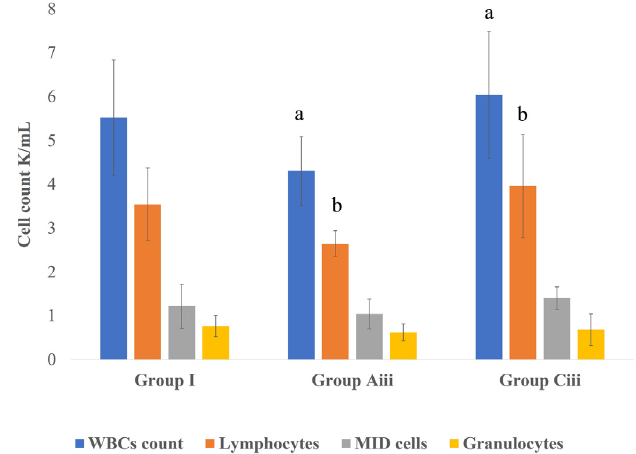
Fig. 11. A chart shows WBCs count results (mean ±standard deviation) of subgroups treated for 2 weeks with either Nigella Sativa (NS) or ( – )-epigallocatechin-3-gallate (EGCG) then, with 7,12- dimethylbenza[a]anthracene (DMBA) combined with either NS (Aiii) or EGCG (Ciii) for 6 weeks as compared to each other and to healthy untreated group (G I). MID: Less frequently occurring cells such as monocytes, eosinophils, basophils and other precursor white cells. ab Indicate that a signi fi cant difference ( P value < 0.05) exists between compared sub/groups that are marked with the same letter.